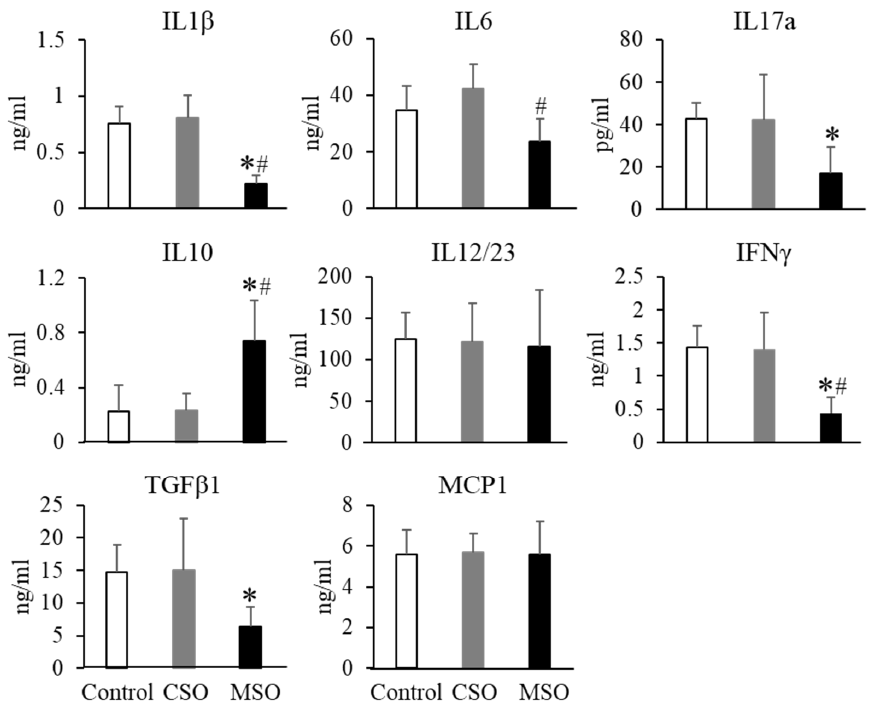
Figure 4. Effects of dietary CSO and MSO on LPS-induced changes in plasma cytokine levels in LDLR-KO mice. Mice (n = 12/group) were fed a Western diet supplemented with 5% ( w / w ) CSO, MSO, or none (control) for 12 weeks. CSO: conventional soybean oil, MSO: modified soybean oil. Values represent the mean ± SEM. * p < 0.05 compared with the control Western diet; # p < 0.05 compared with the CSO diet.